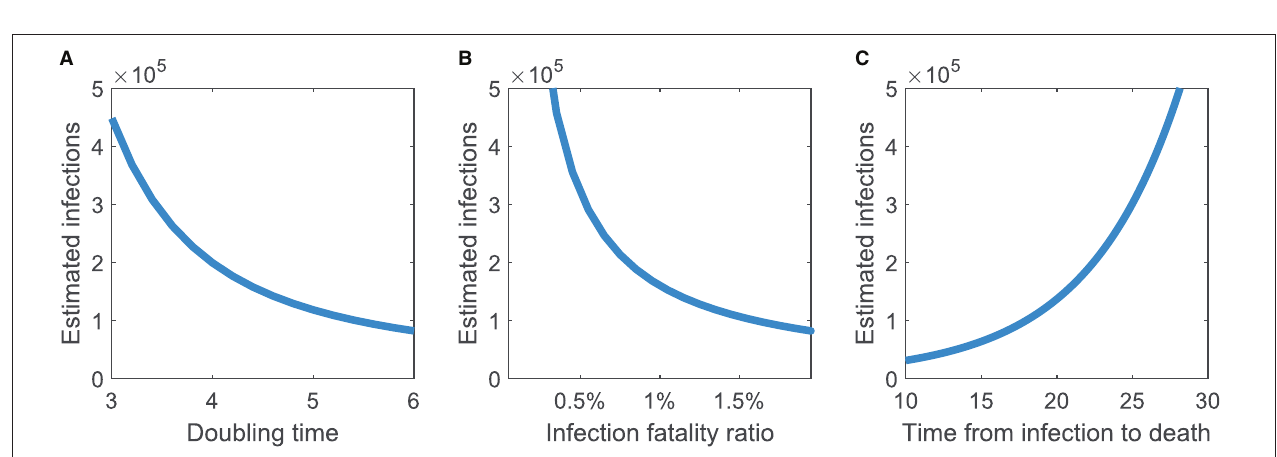
FIGURE 2 | Estimated number of infections assuming exponential growth is robust to small variations in key parameters. How the estimated number of infections depends on (A) doubling time, (B) infection fatality ratio, and (C) average time from infection to death. Parameters not varied are doubling time T = 4, number of deaths d = 100, and infection fatality ratio p = 0.01 (i.e., 1%). Time from infection to death is assumed lognormally distributed with mean 21 days and standard deviation 8 days, except for the right panel where the mean time is given by the horizontal axis.